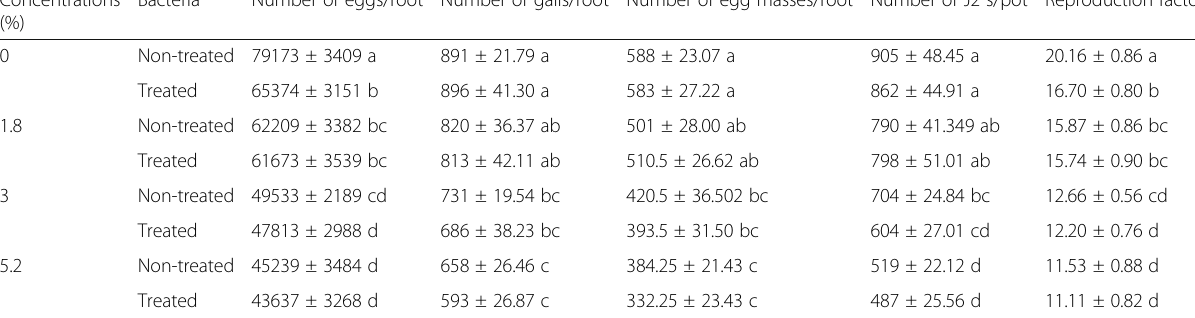
Table 3 Mean numbers of galls, egg masses, and eggs per root, second-stage juveniles (J 2 s) per pot, and reproductive factor (RF) of Meloidogyne javanica after nematode inoculation along with Pseudomonas fluorescens CHA0 incubation of tomato plants and different concentrations of Myrtus communis treated in trials I and II Concentrations